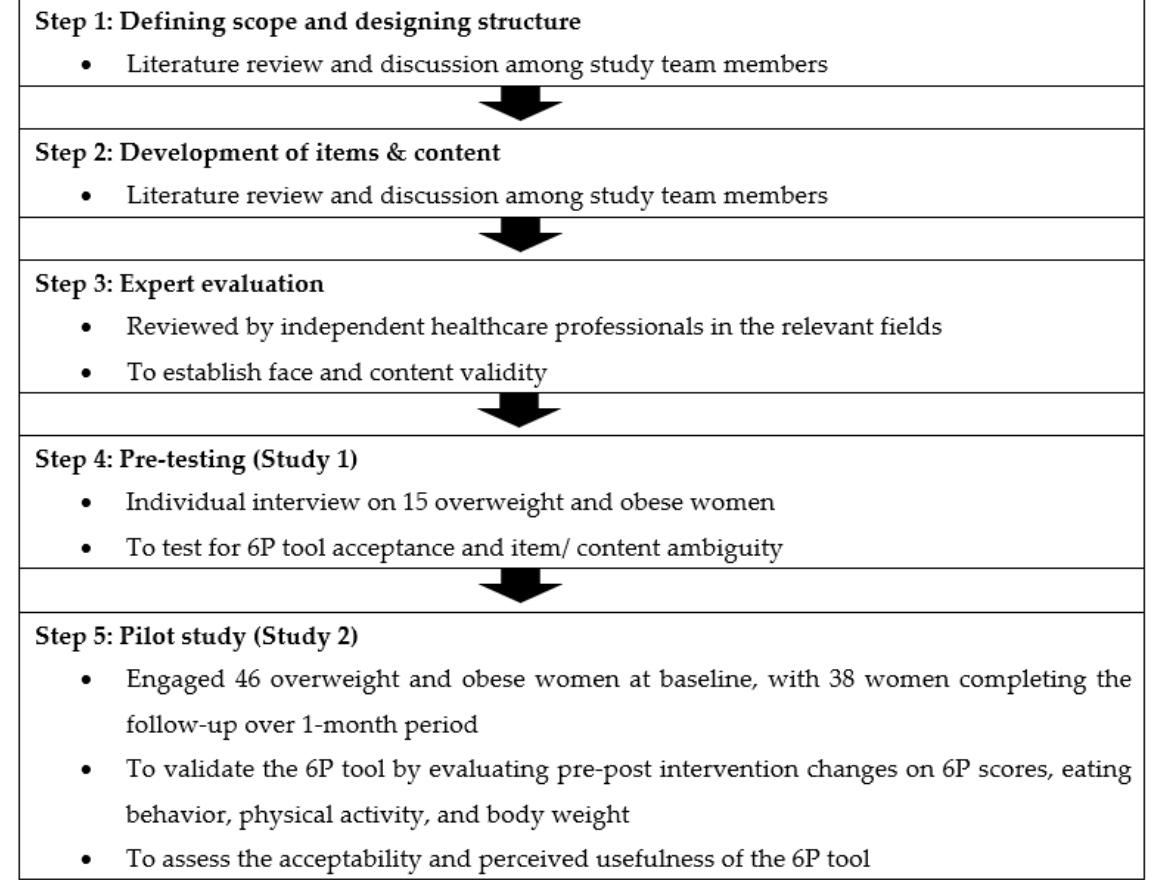
Figure 1. Steps involved in the development and validation of the 6P